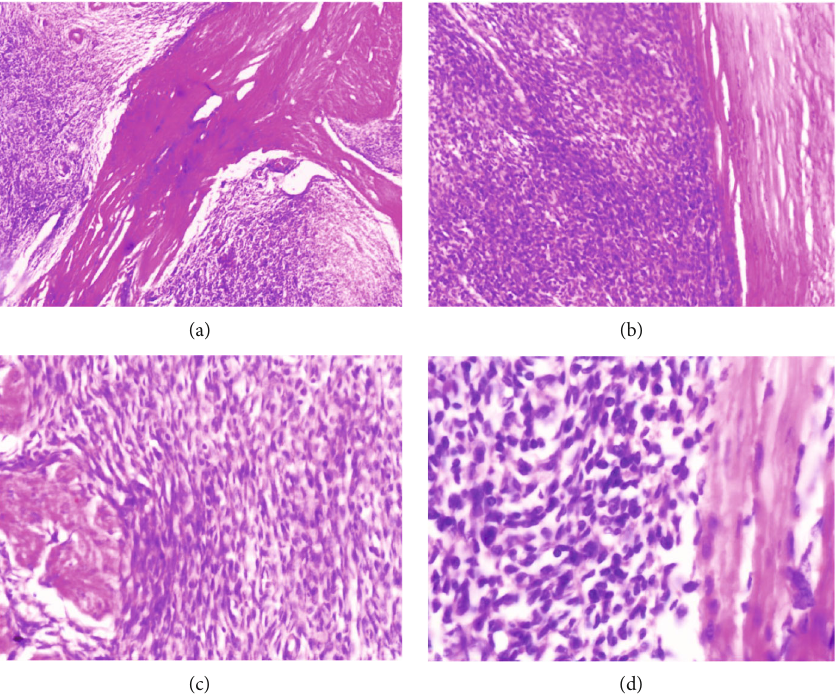
Figure 2: (a) Histopathology showing nodular cellular proliferation of small- to medium-sized, ovoid or spindle cells, which form interlacing bundles, whorls, and broad bands, H&E × 40. (b) In fi ltration of the myometrium, H&E × 100. (c) The tumor cells exhibit only mild nuclear atypia with few mitotic fi gures (2-3/10 HPF), H&E × 200. (d) Higher magni fi cation H&E ×